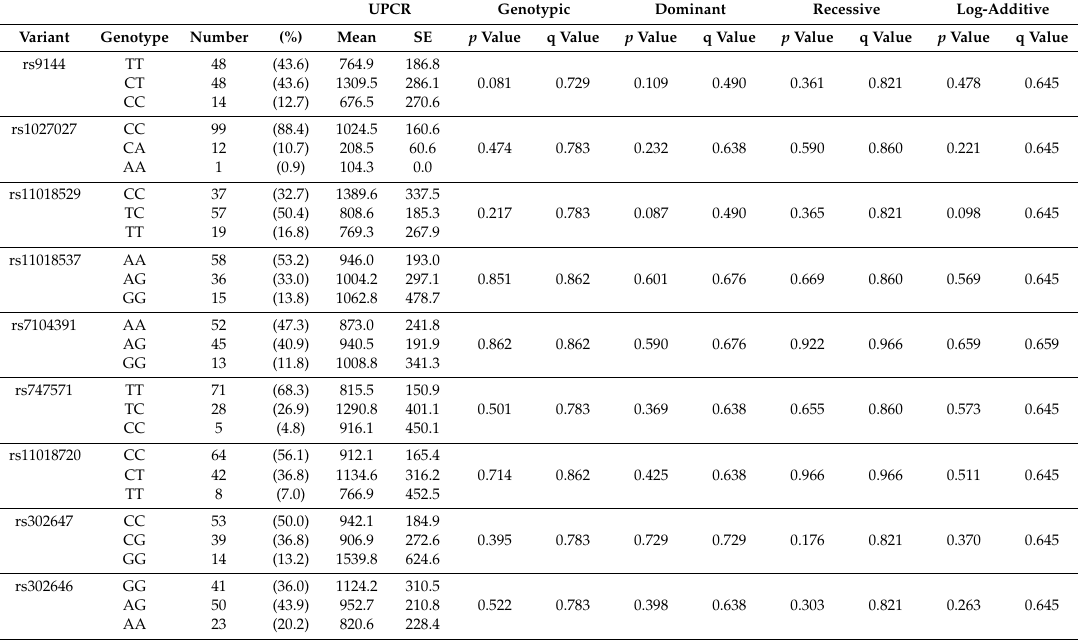
Table 5. Association analysis between RAB38 single-nucleotide polymorphisms (SNPs) and the urine protein and creatinine ratio (UPCR) in the female cohort. UPCR Genotypic Dominant Recessive